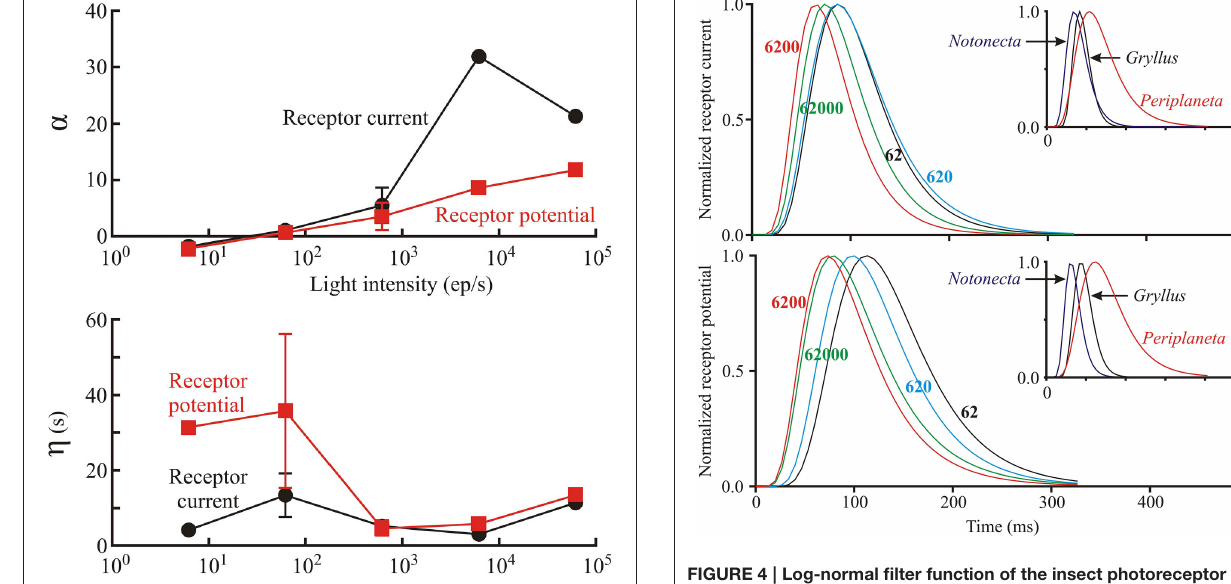
FIGURE 4 | Log-normal filter function of the insect photoreceptor model (Figure 1) for varying light intensities and species. Main plots show curves generated from fitted parameters for both receptor current and receptor potential at four different levels of mean light stimulus (values next to curves in ep/s) in a single photoreceptor cell from Periplaneta . Curves moved to the right at lower light levels, corresponding to slower responses. Insets show similar curves at intermediate levels for three species with different dynamic responses: Notonecta (200ep/s), Gryllus (560ep/s), and Periplaneta